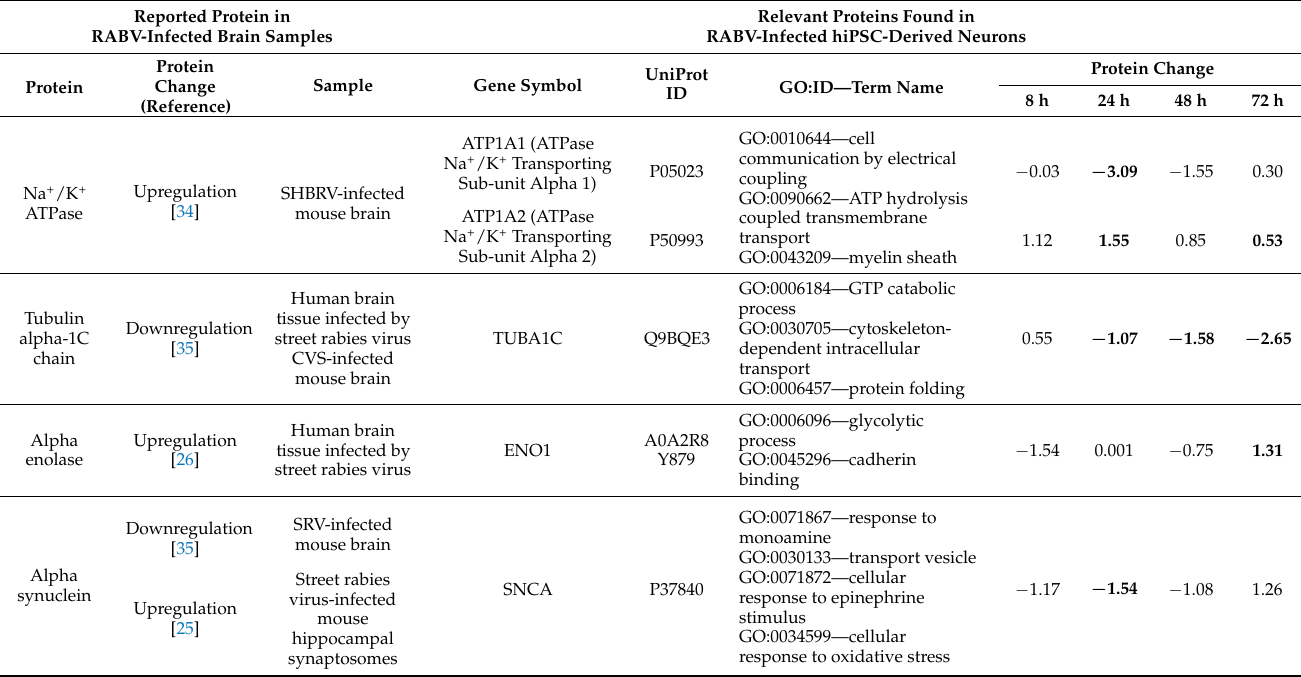
Table 1. Previously identified DEPs in RABV-infected brain samples and DEPs found in RABV-infected hiPSC-derived